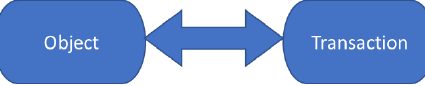
Figure 1. The “Transaction” class should be linked to objects.